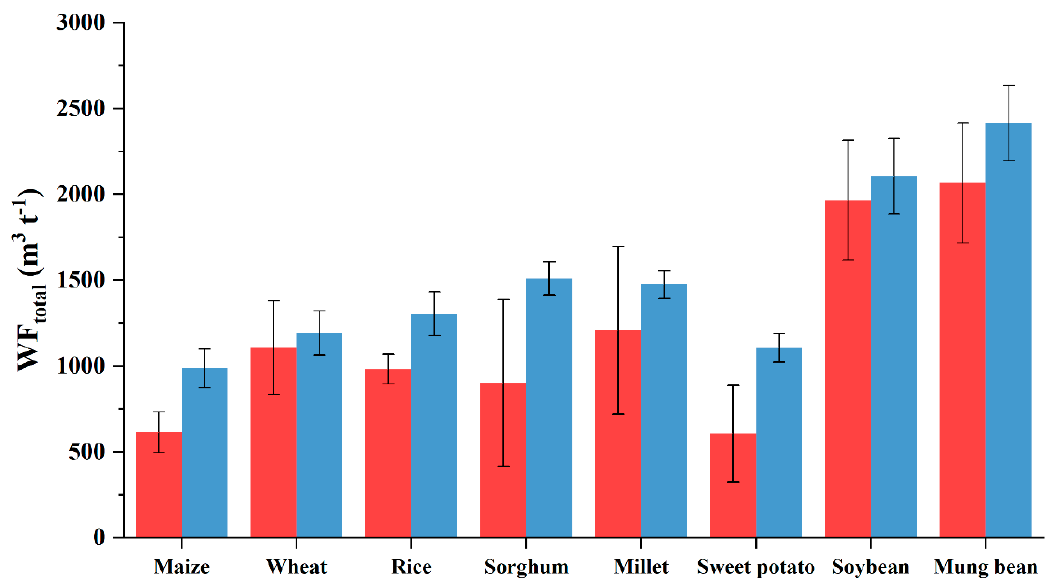
Figure 8. Comparison of WF total under green cultivation in this study (red) and traditional cultivation in previous studies (blue) in the Huang-Huai-Hai farming region. Blue bar data comes from Han et al. [64] Zhang et al. [65] Xie et al. [66] and Dai et al. [67].